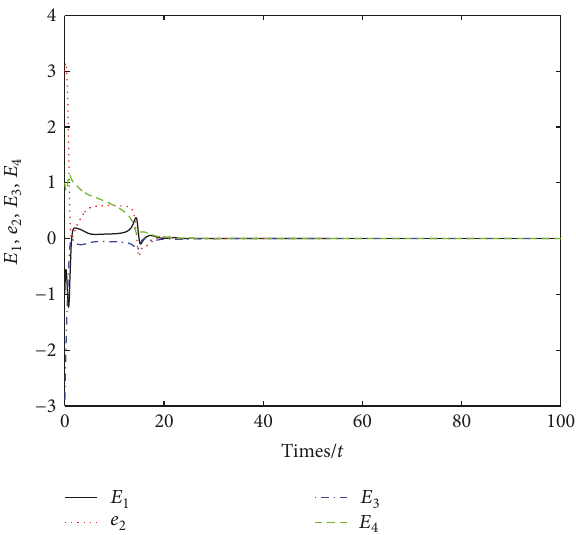
Figure 9: The figure shows that the orbits (𝐸(𝑡),𝑒 2 (𝑡)) 𝑇 of the combination system (35) converge to origin as 𝑡 → ∞ .